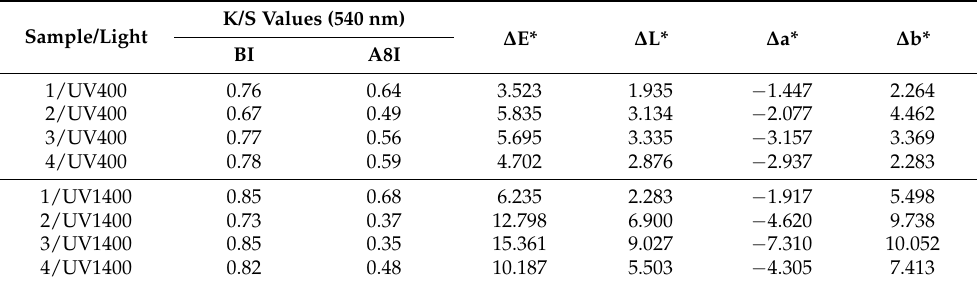
Table 2. Self-cleaning